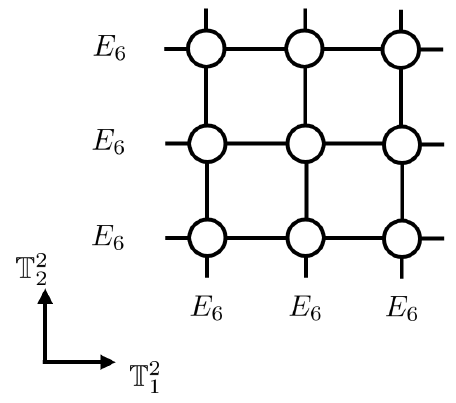
Figure 5 . Depiction of the intersection structure of the six E 6 gauge algebra factors in the T 6 / Z 3 × Z 1 − 1 orbifold. At the nine intersection points, there is ( E 3 − as a